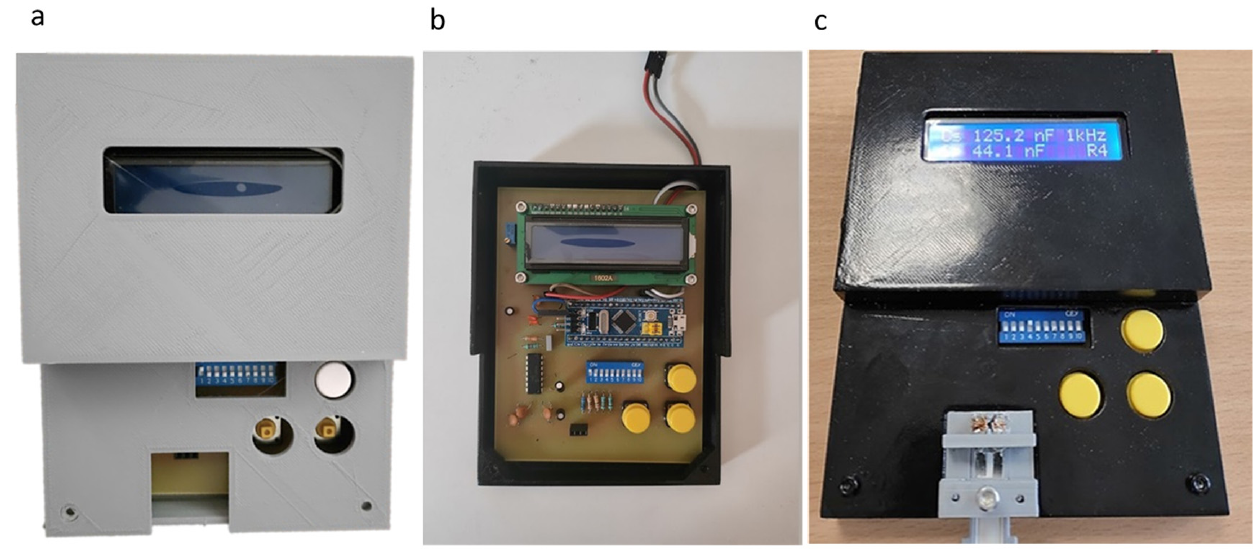
Figure 10. Packaging assembly: ( a ) readout circuit packaging; ( b ) the PCB placed inside the package; and ( c ) the package in its final form displaying the readings of a biosensor in its LCD screen.